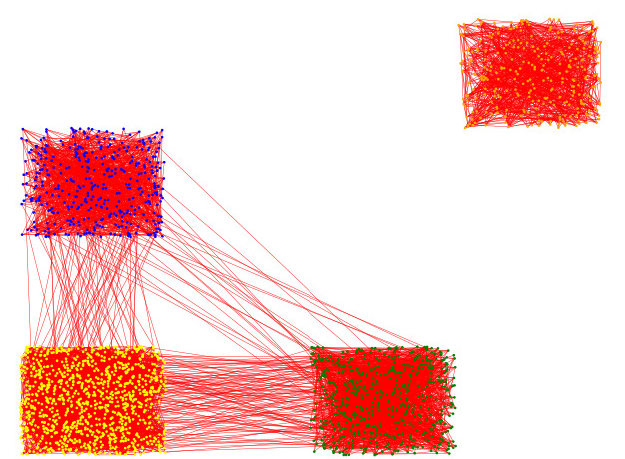
Figure 5. The initial paper research network in the four fields of a , b , c , and d . The yellow dot represents the articles in field a , the green dot represents the article in field b , the blue dot represents the article in field c , and the orange dot represents the article in field d . Points in the network are connected by red edges.